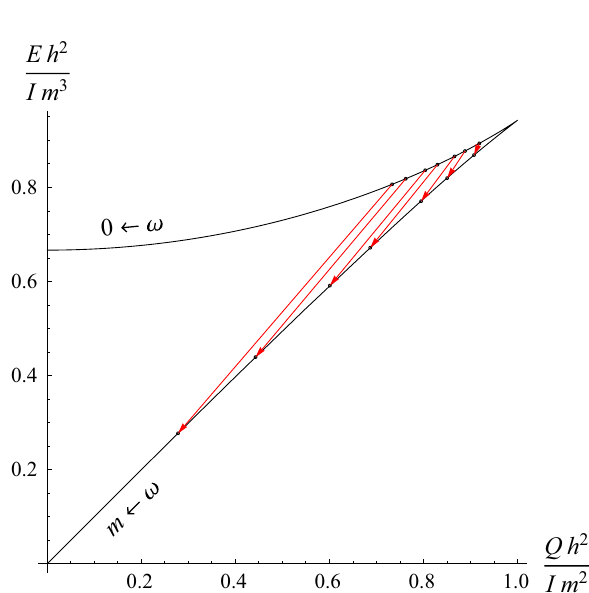
Fig. 11 TransitionsfromclassicallyunstableQ-ballstoclassicallysta- ble Q-balls for 0 . 4 ≤ Ω in ≤ 0 . 55 (see Table 1) on the E ( Q ) diagram